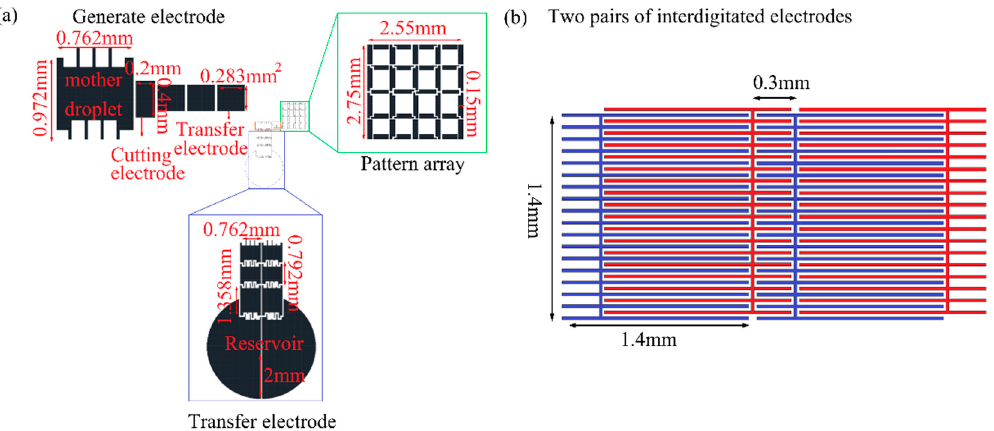
Figure 3. Chip designs: ( a ) electrode mask for an EWOD pattern array; ( b ) two pairs of electrodes in 7 × 6 open interdigitated electrode mask for DEP chip.